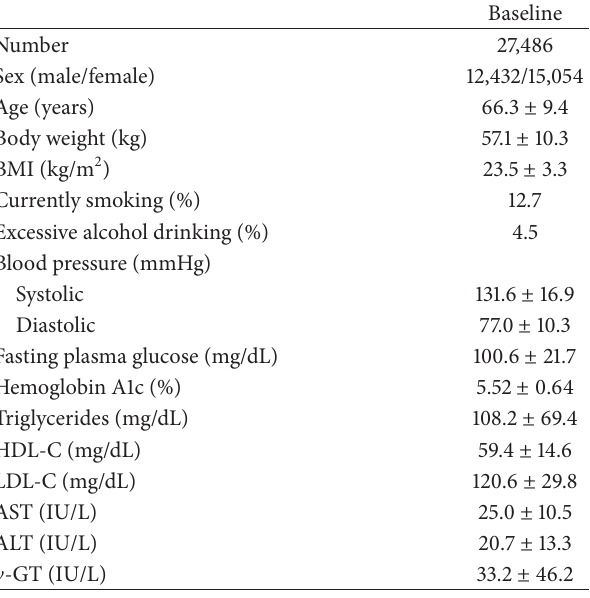
Table 1: Baseline clinical and biochemical characteristics before the Great East Japan